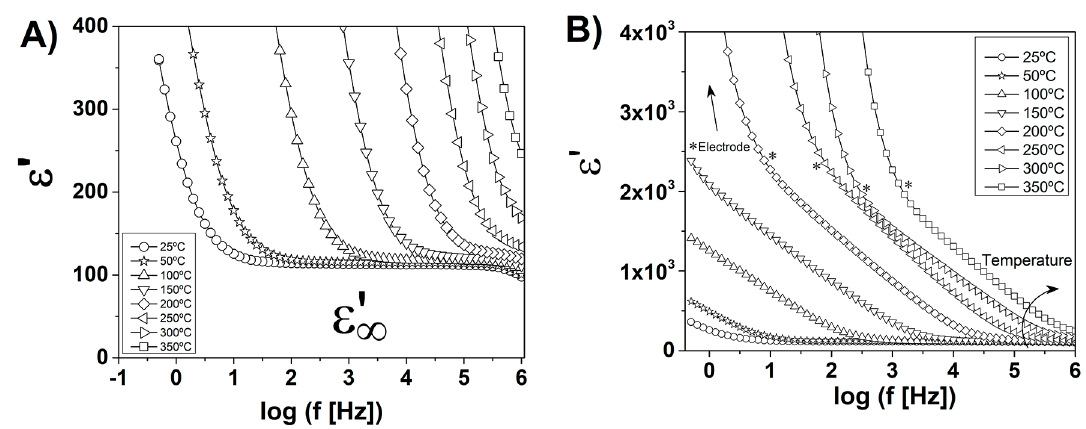
Figure 12. Dielectric permittivity for sample 600–0: A) high frequency phenomena; B) low frequency